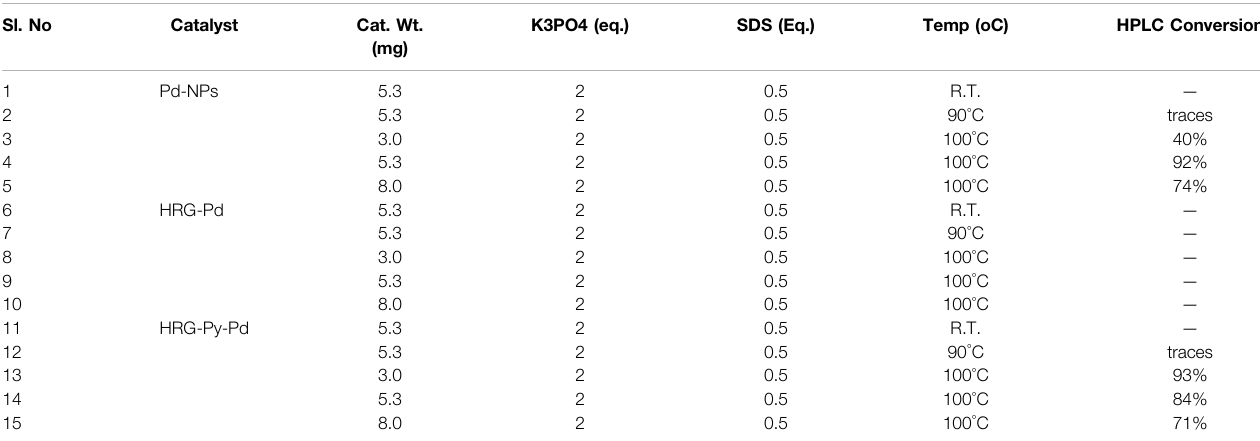
TABLE 1 | Mizoroki-Heck reaction (MH), 4-bromoanisol and acrylic acid as a model substrate. Catalyst screening. Sl. No